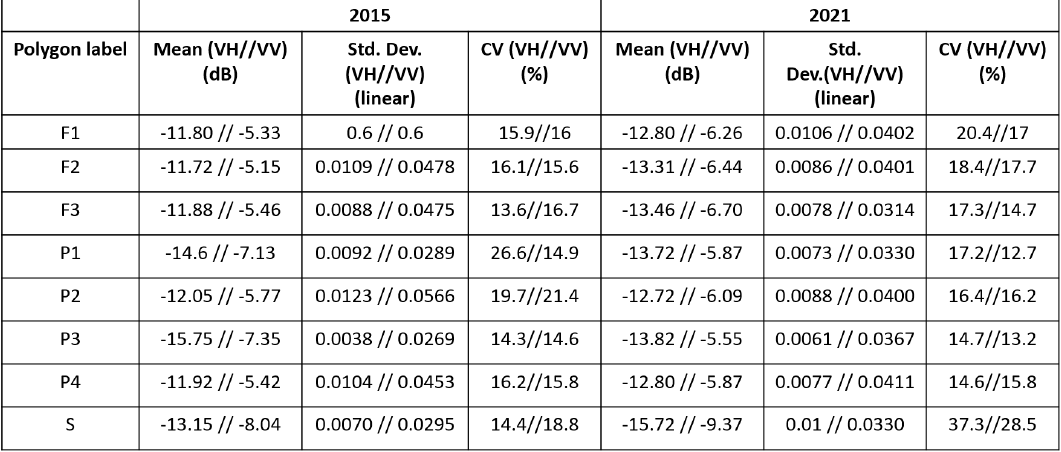
Figure 5. Statistics of all polygons for the initial and final images during the wet season (2015 and 2021, respectively). Mean values are expressed in dB in order to ease comparison with the reported values in the time